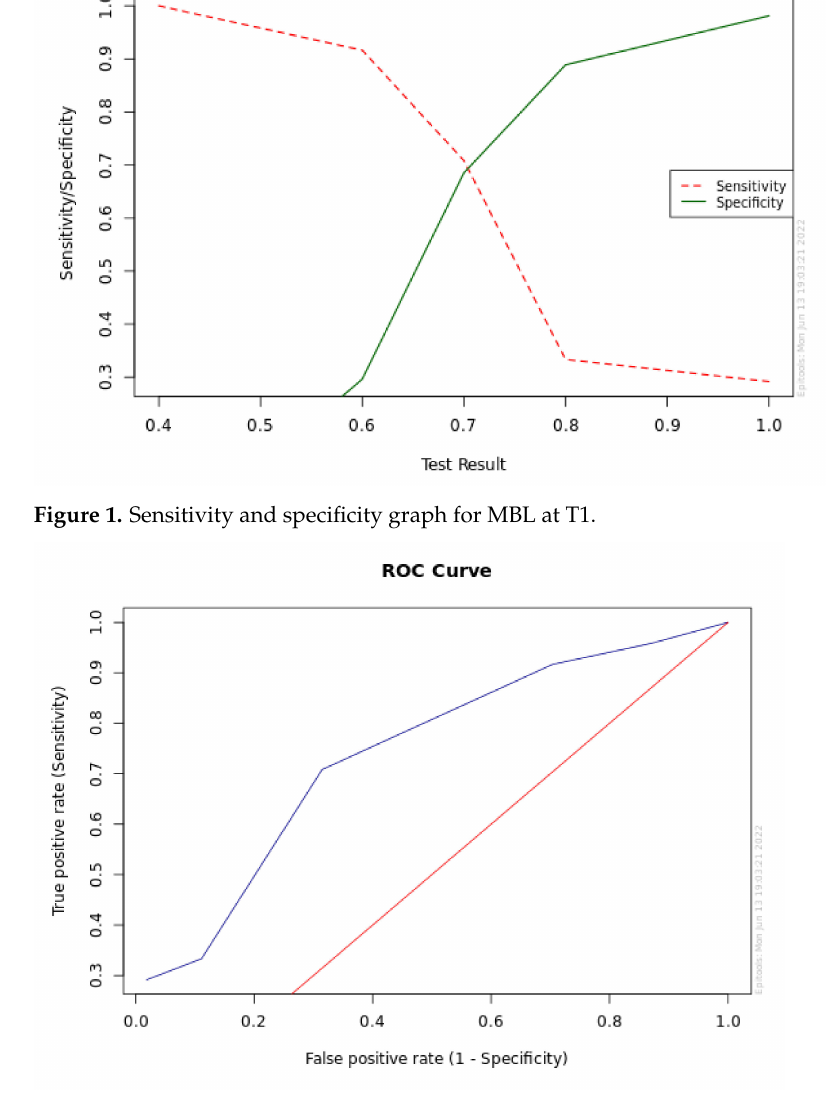
Figure 2. Area under the ROC curve for MBL at T1 (95% CI for AUC). The results indicated that the level of MBL is not determined by chance. At T1, T2, and T6, a-MMP-8 levels and MMP-8 rates were higher in the P+ than the P − group, with a statistically significant difference. A summary of the data for the a-MMP-8 level at T1 is reported in Table 5. Table 5. Summary of data for a-MMP-8 level at